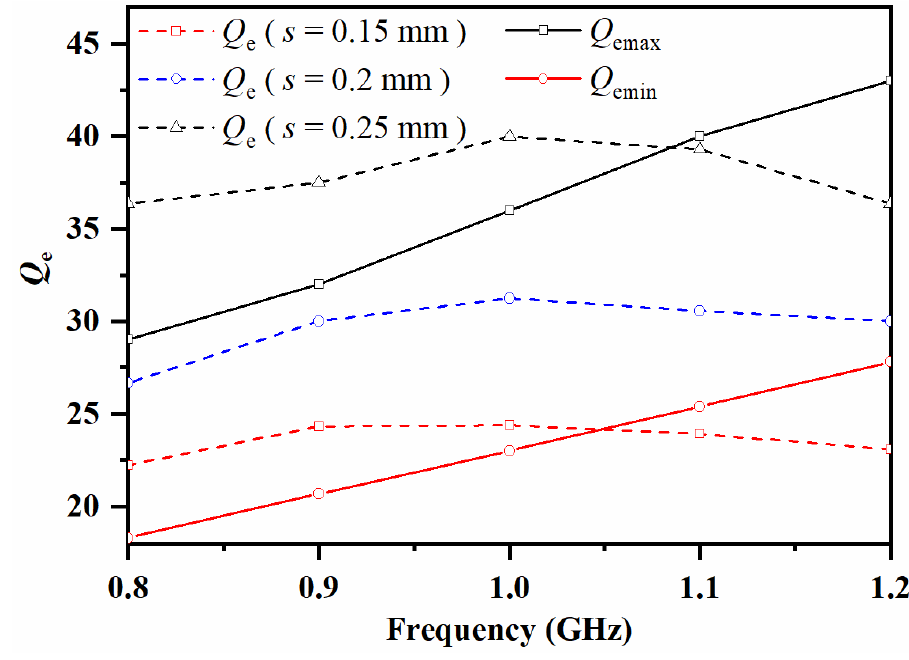
Figure 10. Desired and extracted Q e .